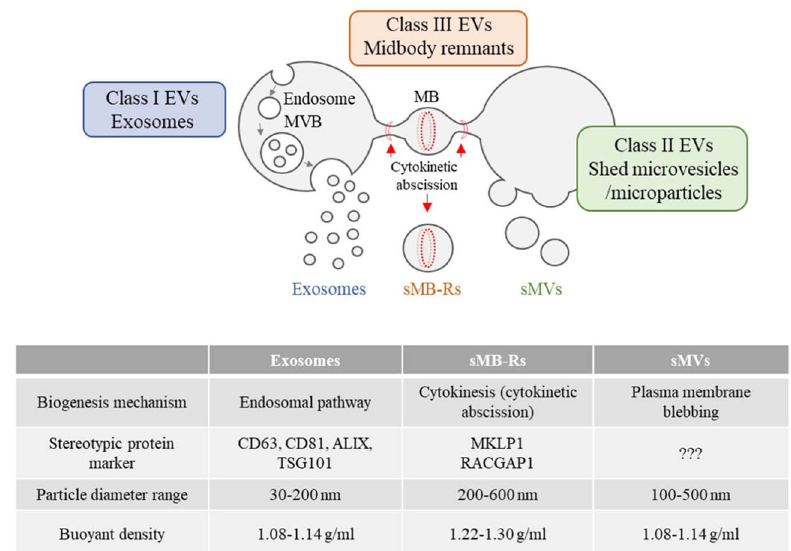
Fig. 6 Schematic illustration of three distinct classes of extracellular vesicles – exosomes, shed microvesicles/microparticles and shed midbody remnants (sMB-Rs). Exosomes (class I EVs) are of endosomal origin (formed by invagination of multivesicular bodies (MVB)), shed microvesicles/ microparticles (class II extracellular vesicles) are formed via direct outward blebbing of plasma membrane and midbody remnants (MB-Rs) (class III extracellular vesicles) are generated by cytokinetic abscission of the interconnecting bridge between dividing daughter cells (post completion of cytokinesis). Current understanding of biophysical properties and stereotypic marker proteins for exosomes, sMVs (microparticles) and sMB-Rs are listed in the table. Centraspindlin complex proteins MKLP1 and RACGAP1 enable distinction of sMB-Rs from exosomes and